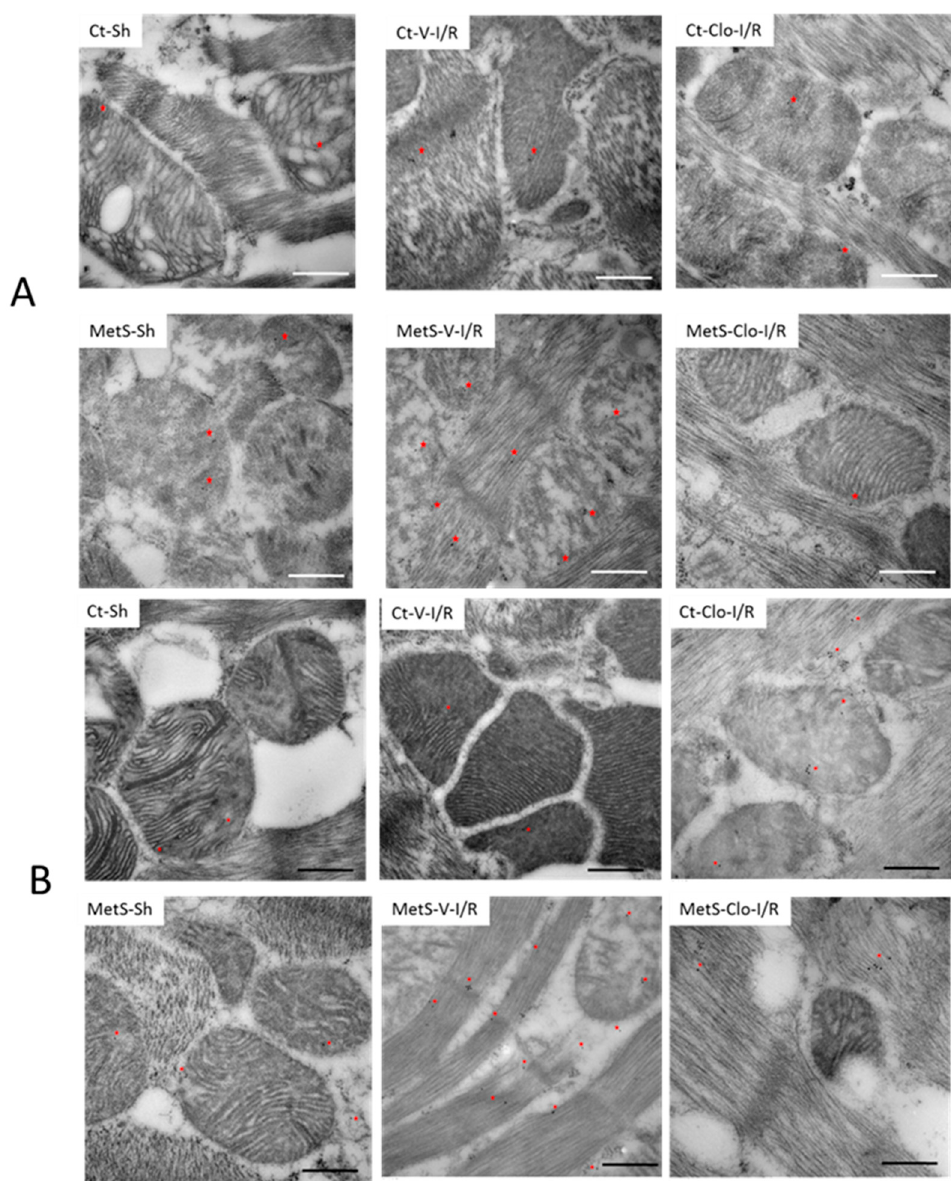
Figure 7. Expression of atrial natriuretic peptide (ANP) and atrial natriuretic peptide receptor (ANPr) in fibers and mitochondria of hearts from MetS rats under ischemia/reperfusion injury. Representative immune-electron micrograph for ANP ( A ) and ANPr ( B ) of left ventricles from control (Ct) and metabolic syndrome (MetS) rats subjected to sham (Sh) or ischemia/reperfusion (I/R) damage and treated with either vehicle (V) or clofibrate (Clo). The images show the signal (red asterisk) obtained by 15 nm gold particles in the different treatments. Ultrastructural alterations in fibers and mitochondrial architecture in I/R-damaged groups are also evident, such as amorphous matrix densities and severe mitochondrial swelling. Bar = 500 nm.